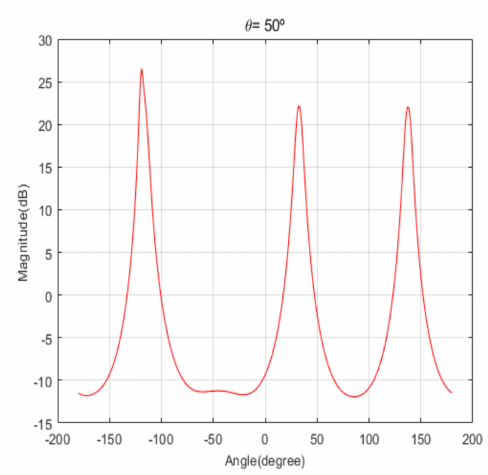
Figure 5. Spatial spectrum of CAPON for the first scenario (elevation angle = 50 ◦ ).